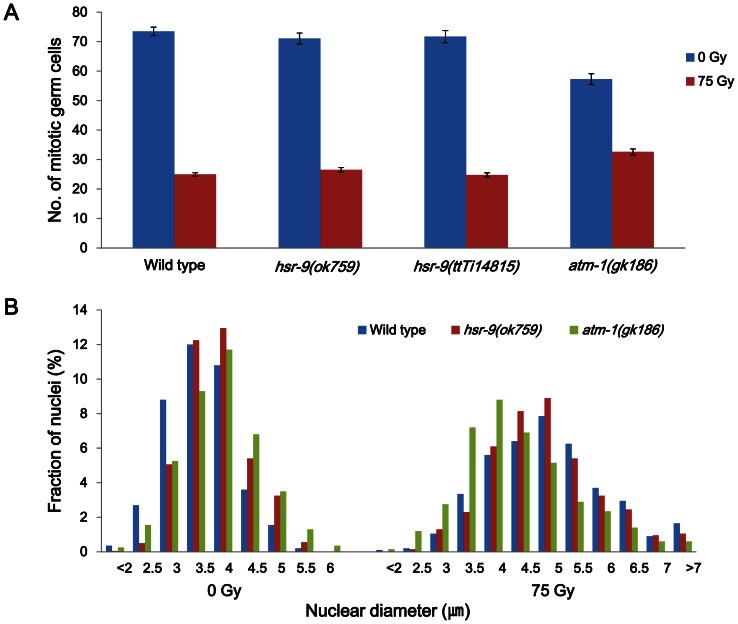
Cell cycle arrest in response to γ-rays is normal in the hsr-9(ok7599) mutants.Wild-type N2, hsr-9(ok759), hsr-9(ttTi14815), and atm-1(gk186) worms were treated with 75 Gy of γ-irradiation as L4 stage larvae. Twelve hours later, gonads were isolated and stained with DAPI. (A) Germ cells in the mitotically proliferating regions of the gonads (within 75 µm of the distal tip cell) were counted under a fluorescence microscope (30 gonad arms per data point). (B) The diameters of 40 nuclei in the mitotically proliferating region of each gonad arm were measured (number of nuclei  = 800 for each strain before and after irradiation) for wild-type N2, hsr-9(ok759), and atm-1(gk186) worms. The percentages of the total nuclei of different diameters are plotted. Very small (<2 µm) and very large (>7 µm) nuclei were grouped together.